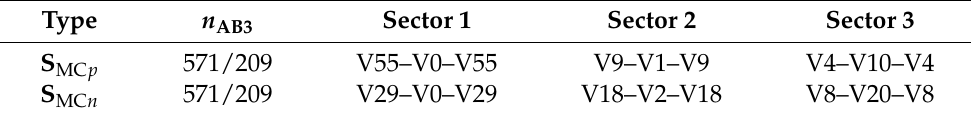
Table 5. Example the switch states sequences in the first 3